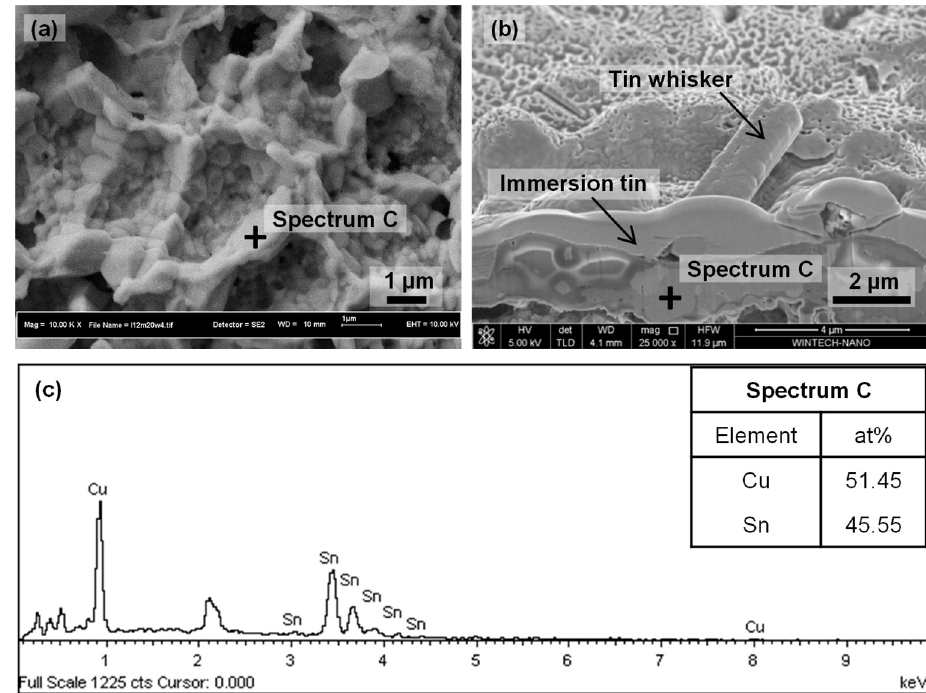
Figure 11. FESEM micrographs of IMCs on 1.5 µm tin coating from ( a ) top and ( b ) cross-sectional views after 20 weeks of storage at 30 °C/60% RH. The EDX spectra of IMCs is shown in ( c ) with elemental composition in the table inserted in ( c ).